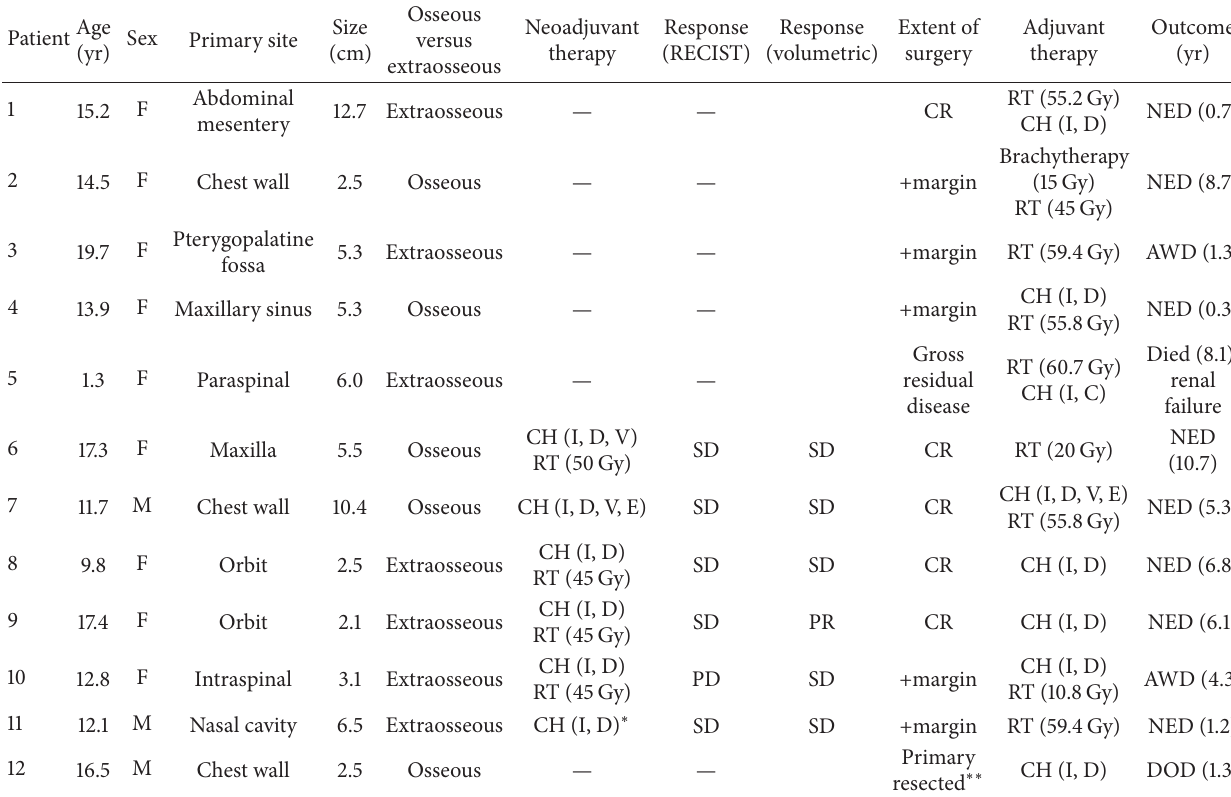
Table 1: Characteristics, treatment, and outcome of children and adolescents with mesenchymal chondrosarcoma. Age Patient (yr)